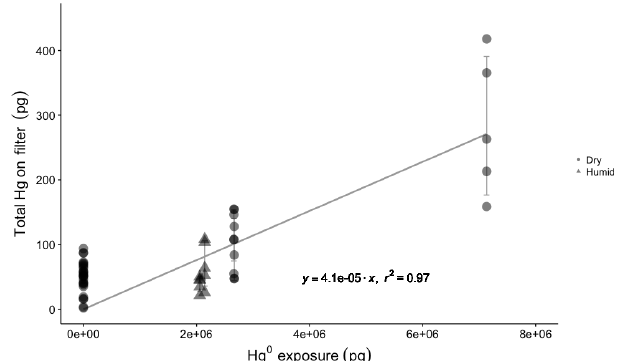
Figure 2. Total Hg recovered on CEM material for blank filters (Hg exposure = 0pg) and different Hg 0 vapor permeations in dry (0 . 5 ± 0 . 1gm − 3 WV) and humid air (2–4gm − 3 WV). Circles rep- resent dry air permeations, triangles represent humid air exposures, and all permeation exposures were blank-corrected. The regression line shows the relationship between total Hg 0 exposure and blank- corrected mean total Hg recovered on CEM filters (error bars ± one standard deviation), with a slope of 4 . 1 × 10 − 5 indicating a linear uptake rate of